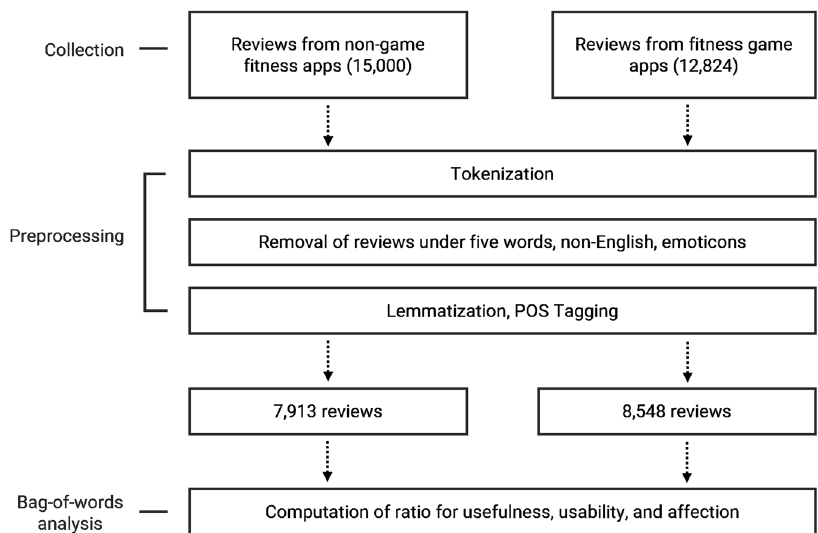
Fig. 1 Data pre-processing procedures on the collected reviews from Google Play